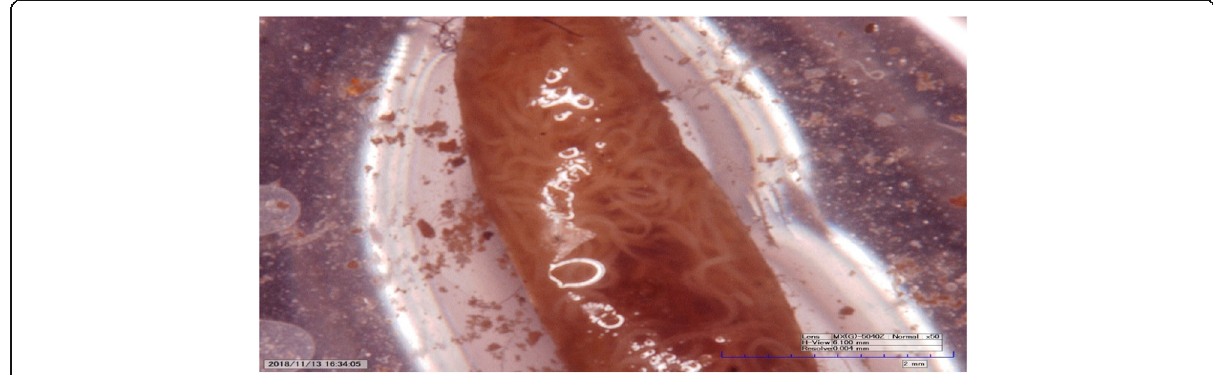
Fig. 3 Last instar lar ν ae ο f Ceratitis capitata parasitized by Steinernema feltiae seen under a stereomicr ο sc ο